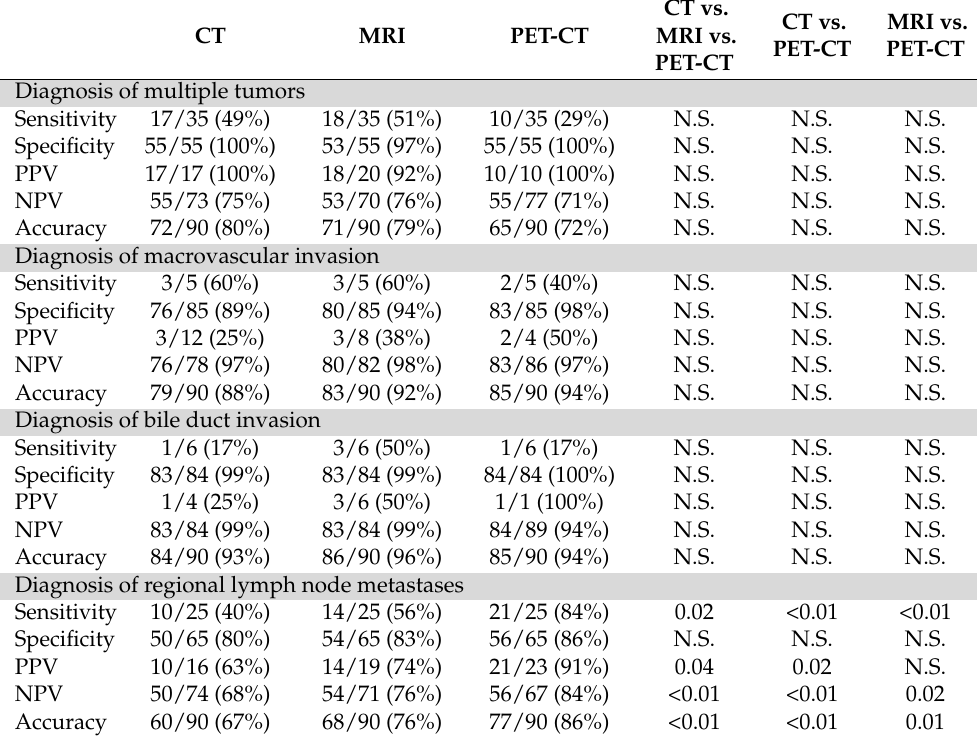
Table 2. Diagnosis of multiple tumors, macrovascular invasion, bile duct invasion, regional lymph node metastases, and distant metastases by imaging